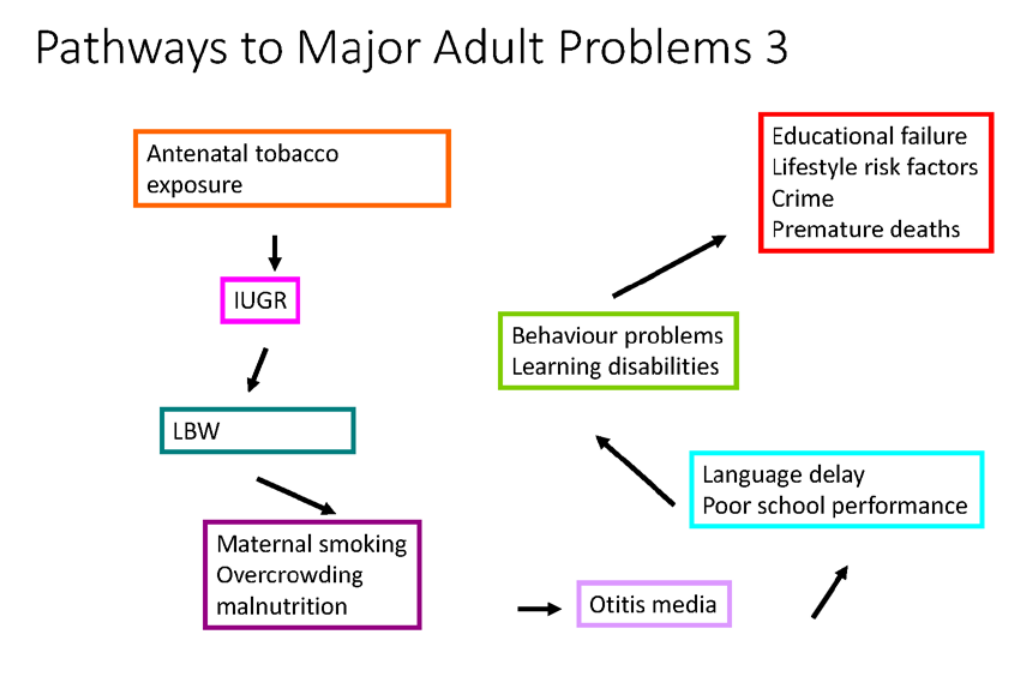
Figure 2. Pathways to major adult problems. IUGR: intrauterine growth restriction. LBW: low birth